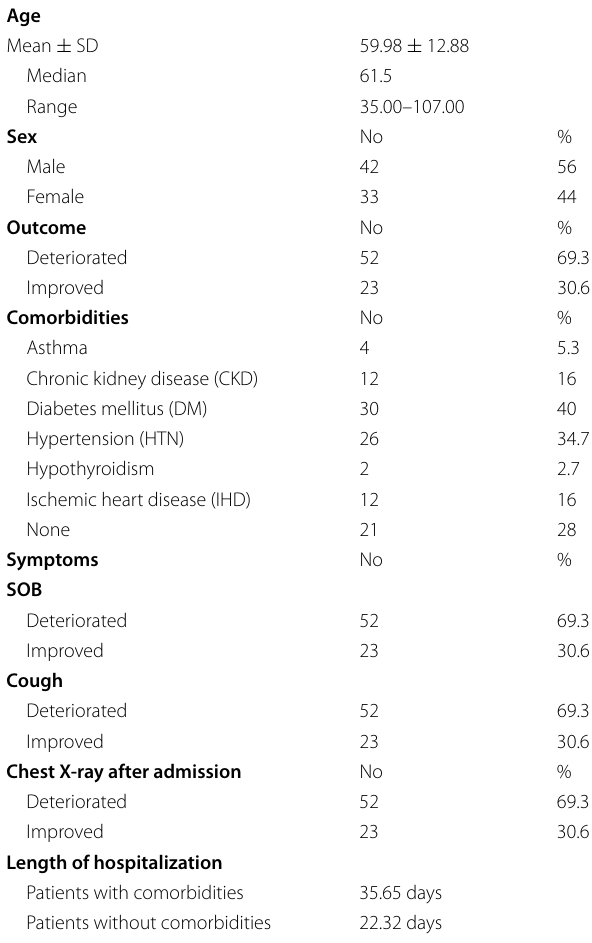
and after admission (Table 3).